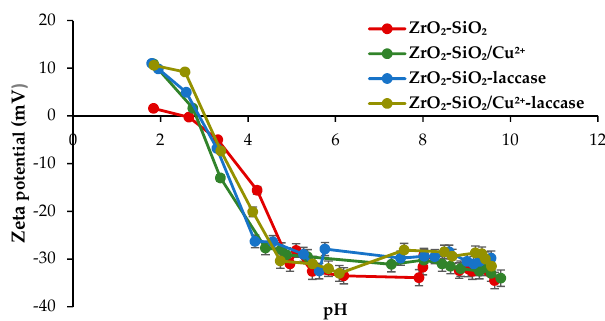
Figure 5. Electrokinetic curves of the synthesized materials and biocatalytic systems.